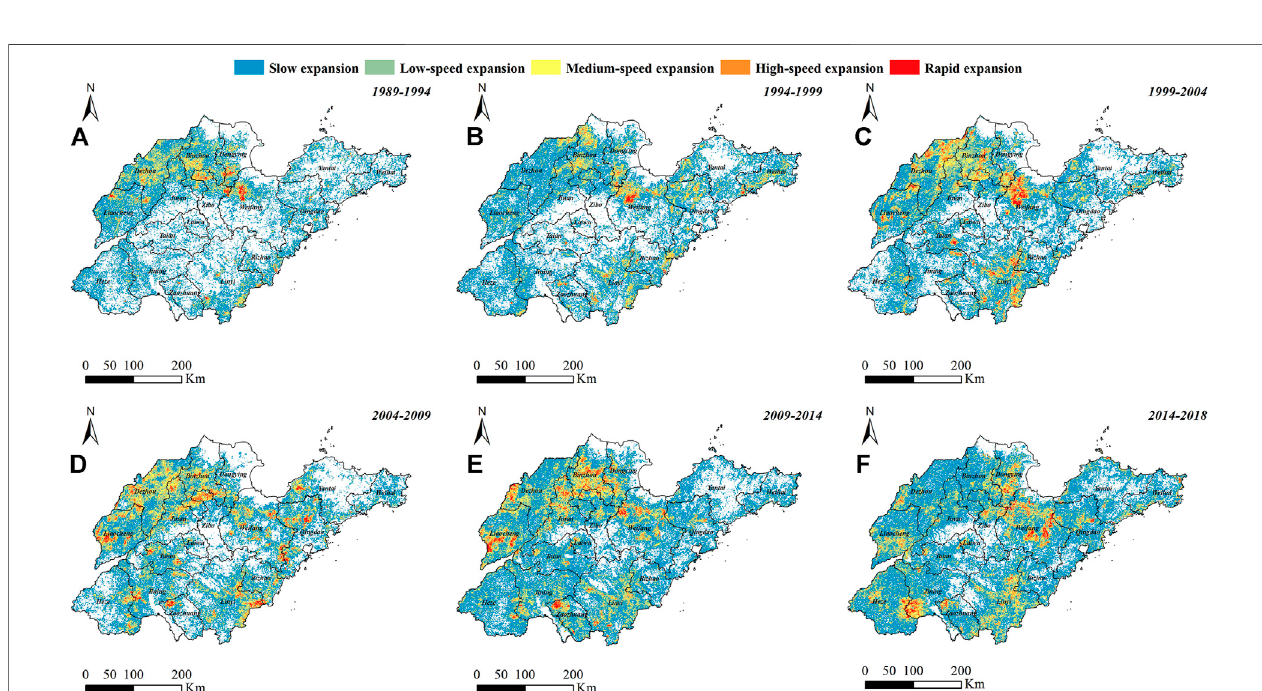
FIGURE 7 | The expansion intensity patterns of GCL at different periods: (A) period 1989 – 1994, (B) period 1994 – 1999, (C) period 1999 – 2004, (D) period 2004 – 2009, (E) period 2009 – 2014, (F) period 2014 – 2018.